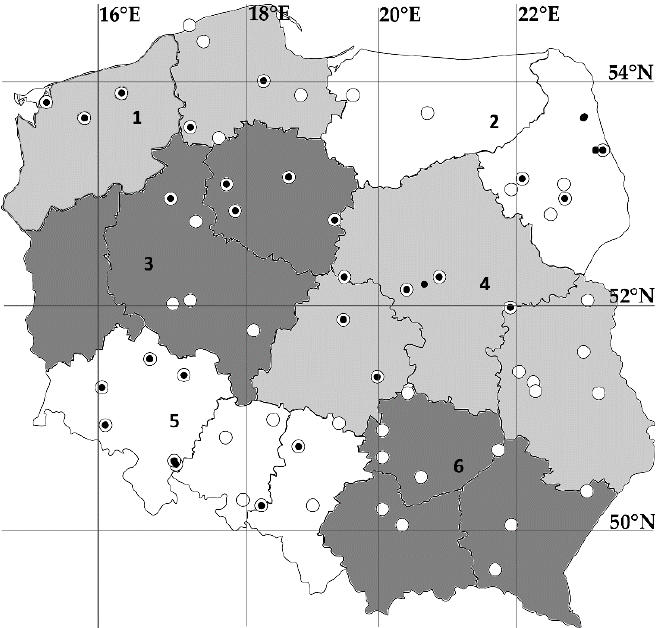
Figure 1. Locations of the winter triticale (blank dots) and spring triticale (solid dots) experiments which took place between 2009/2010 and 2016/2017 in Poland. Lines display the 16 Polish adminis- trative units (voivodeships) and shades indicate the six regions used in the analysis. Grid straight lines represent the geographic coordinate system for Poland.